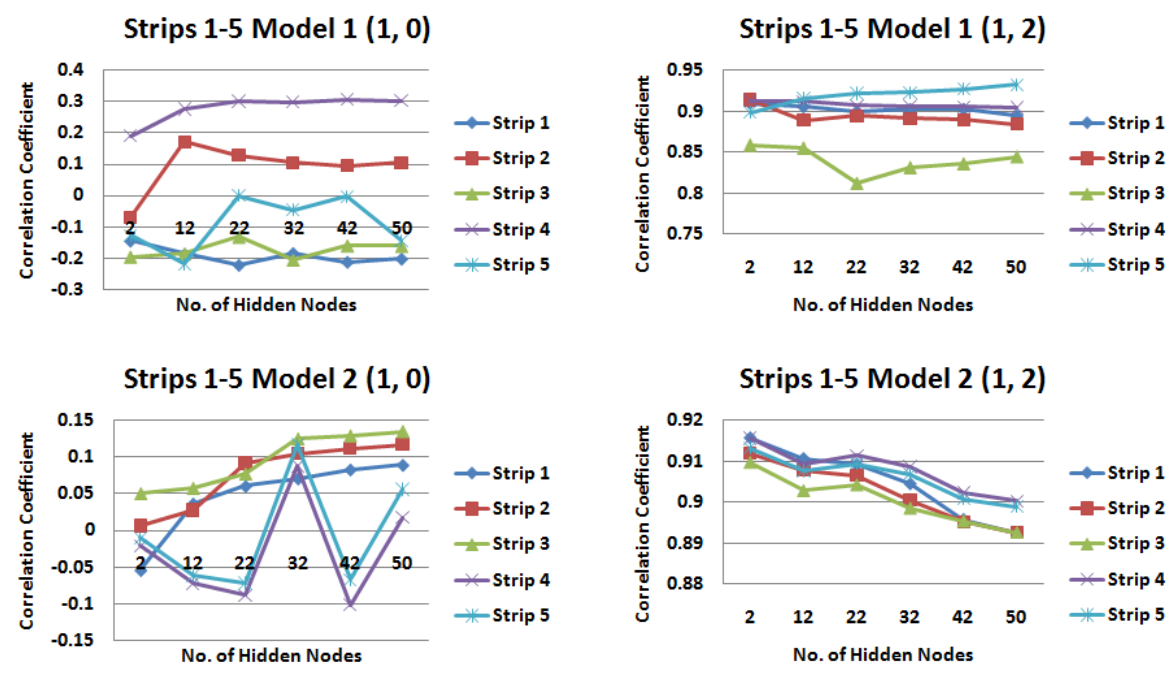
Figure 7. Correlations for input models 1 and 2 for 1 day rainfall information and 0 and 2 days water level information for each strip of the catchment.